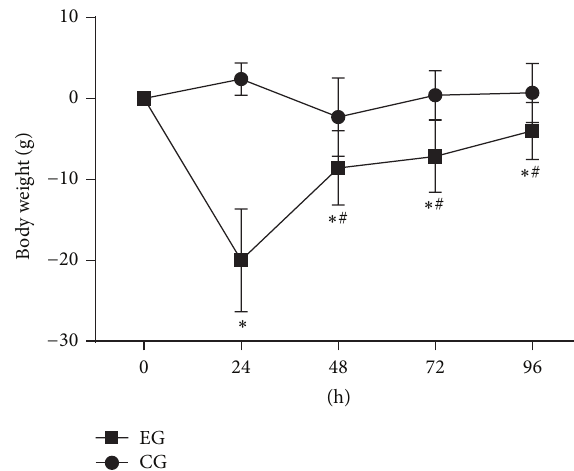
Figure 1: Weight variation during each 24h of SD. Control group (CG), experimental group (EG). The data are shown as the mean ± standard deviation. ( ∗ ) Difference between EG and CG and ( # ) difference from those 24h, within the same group. 𝑃 < 0.05 .